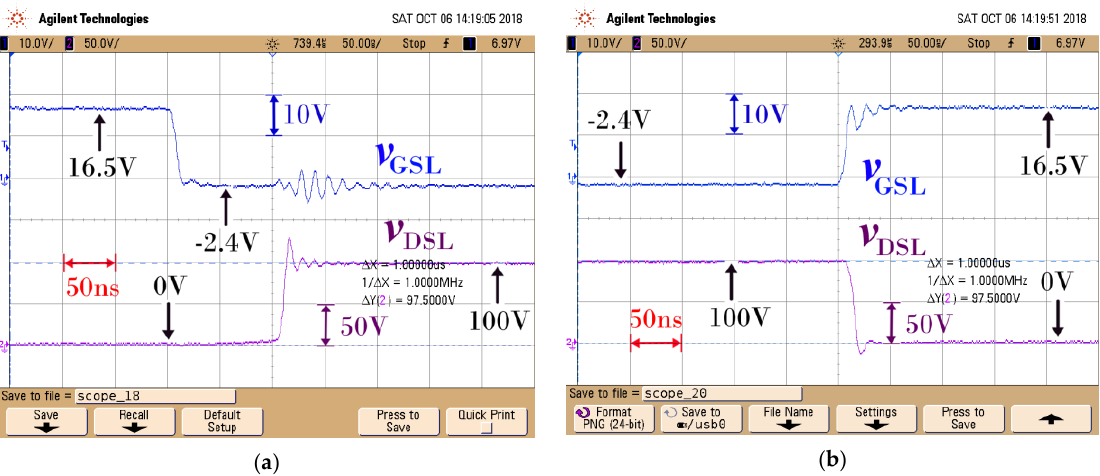
Figure 14. Experimental switching waveforms without snubber ( a ) turn-off, and ( b ) turn-on of low-side SiC MOSFET.